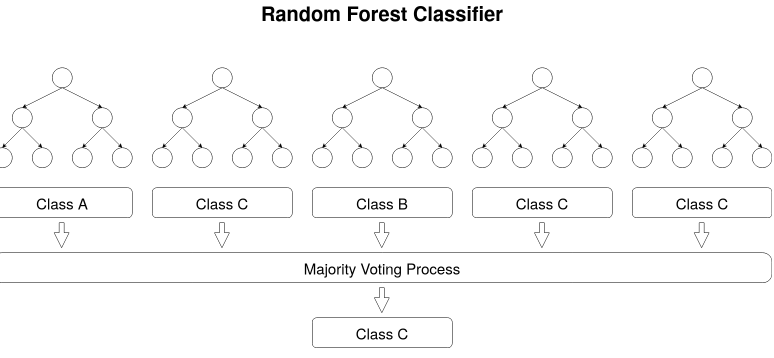
Figure 1. Representation of Random Forest prediction process.